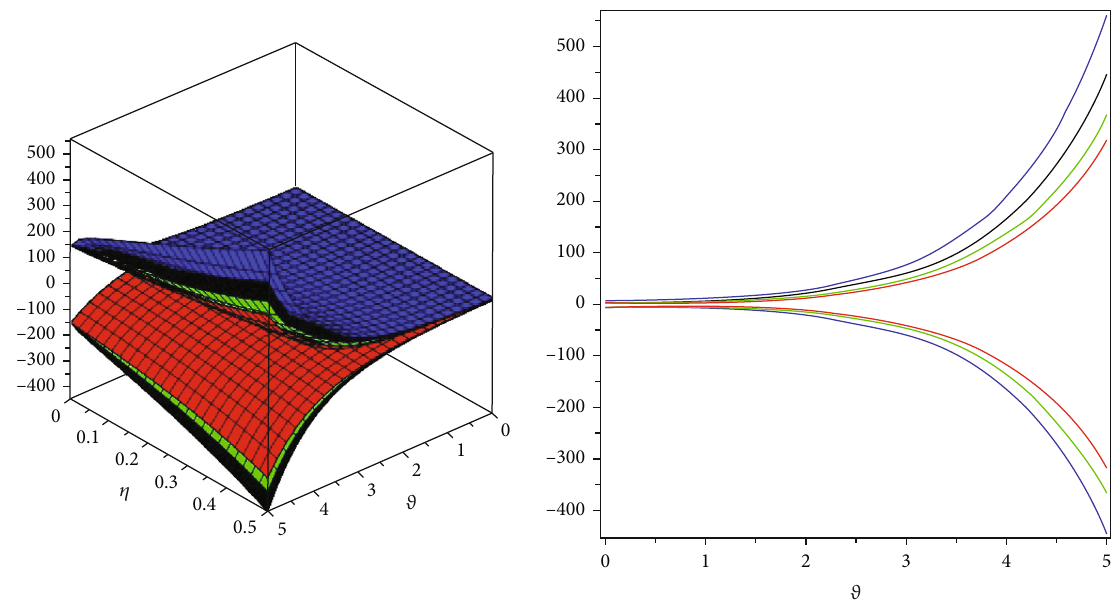
Figure 6: The various fractional order ϱ fi gures of upper and lower branches of analytical